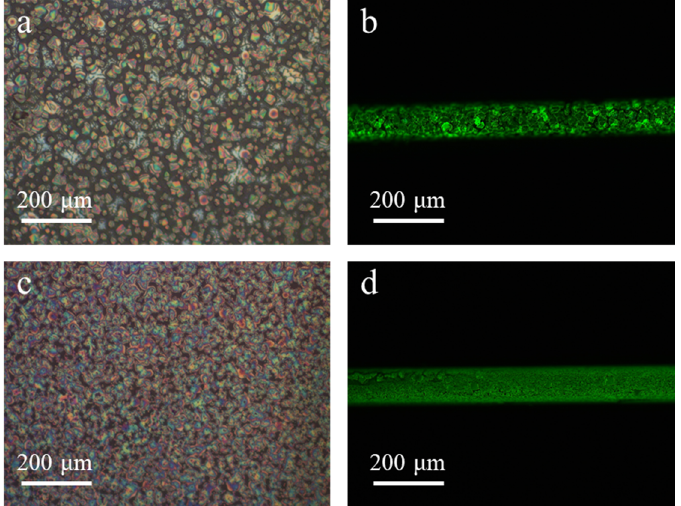
Figure 2. Neat film assembly with NdBr 3 additives. ( a ) Spontaneous crystallization assembly on a